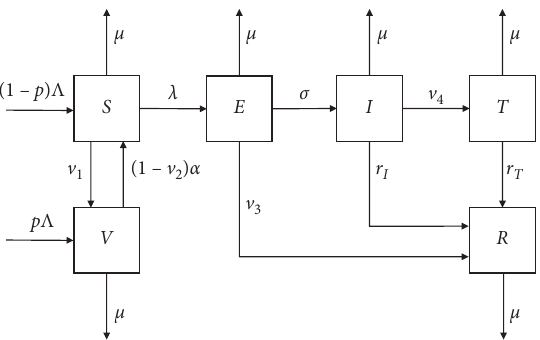
Figure 1: Compartmental model of measles transmission. Table 1: Description parameters of the